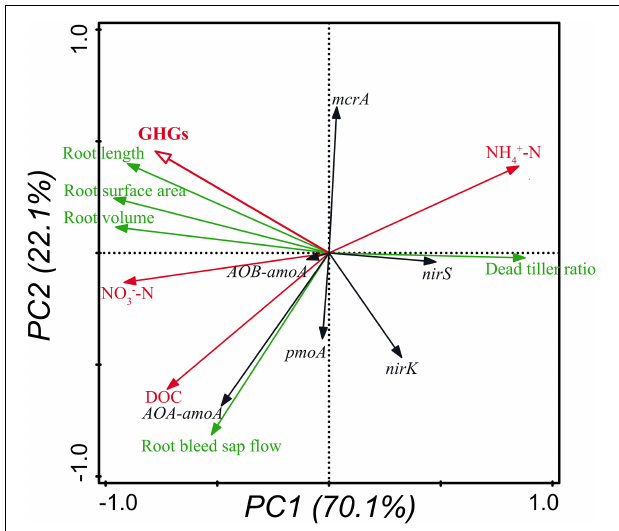
FIGURE 3 | Relationships of GHGs with the growth of rice plants, soil chemical properties and GHG-related microorganisms shown by PCA. GHGs and soil chemical properties are denoted by hollow and solid red arrows, respectively. Attributes of rice plants are denoted by green arrows, and soil microorganisms are denoted by black arrows. The abundance of genes was measured in triplicate per